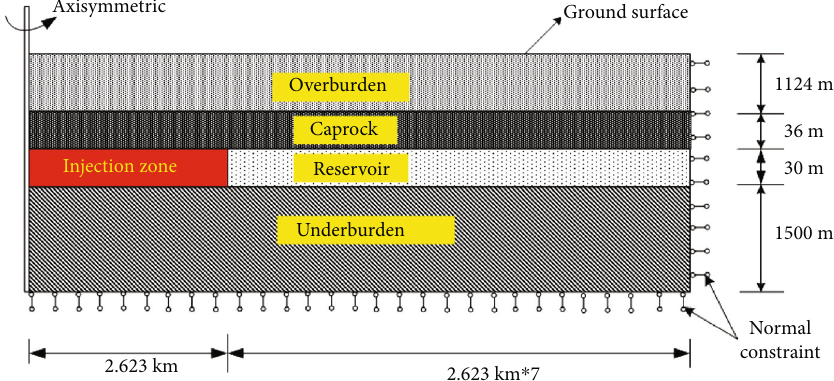
Figure 6: 2D axisymmetric model.